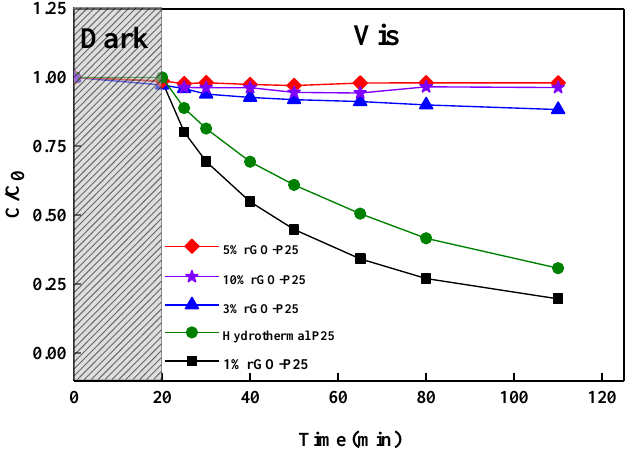
Figure 4. Effect of contents of rGO on BPA degradation by rGO – P25 under visible light irradiation Figure 4. E ff ect of contents of rGO on BPA degradation by rGO–P25 under visible light irradiation (BPA (BPA concentration = 0.01 mol/L, catalyst dosage = 0.5 g/L, volume of the solution = 100 mL, λ = 420 concentration = 0.01 mol / L, catalyst dosage = 0.5 g / L, volume of the solution = 100 mL, λ = 420 nm, 10 nm, 10 tubes).